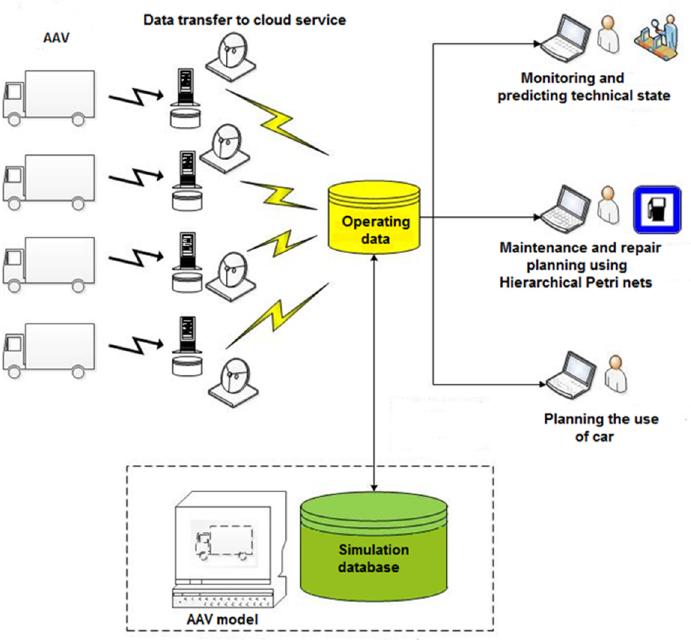
Figure 8. Predictive maintenance system for autonomous agricultural vehicles.